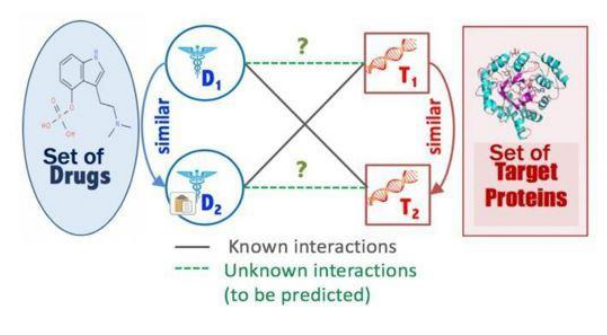
Figure 2. interaction